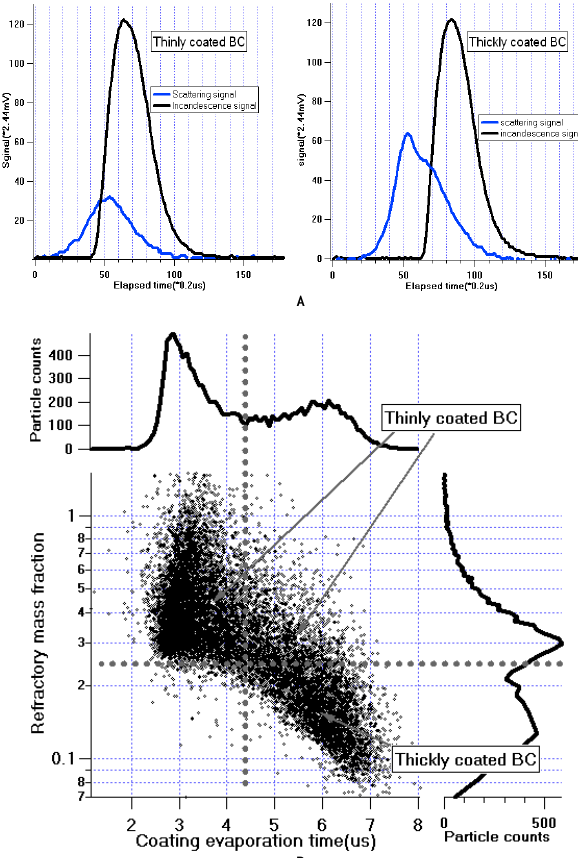
Fig. 4. (A) Two examples of detected rBC in single particles, both having the same size of rBC core but the left one is less or rela- tively thinly coated compared to the thickly coated one on the right. (B) the refractory mass fraction related to the coating evaporation time, the upper and right lines show the histograms of x-axis and y-axis values respectively, units are particle counts. The definitions of thickly-coated and thinly-coated BC are